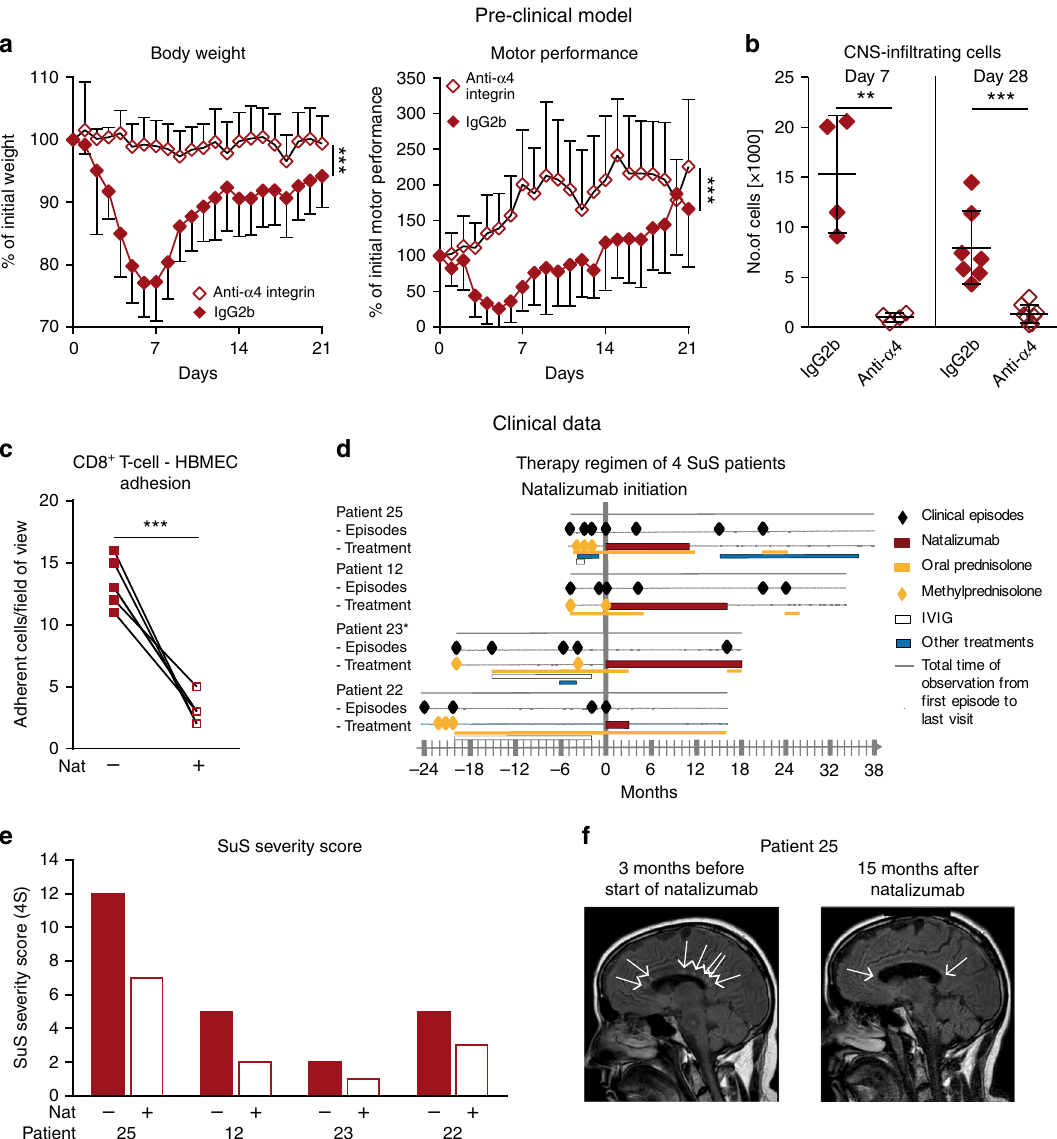
Fig. 7 Effects of anti-VLA4 mAb in a preclinical and clinical setting. a , b Preclinical data. a EC-HA + mice received HA-speci fi c cytotoxic CD8 + T cells and were treated every 4 days with the anti-mouse α 4 integrin mAb (PS/2; open cayenne diamonds) or with an isotype control mAb (IgG2b; closed cayenne diamonds) from day 0 onwards. Clinical signs including weight loss (left) and rotarod performance (right) were assessed daily. The data are from